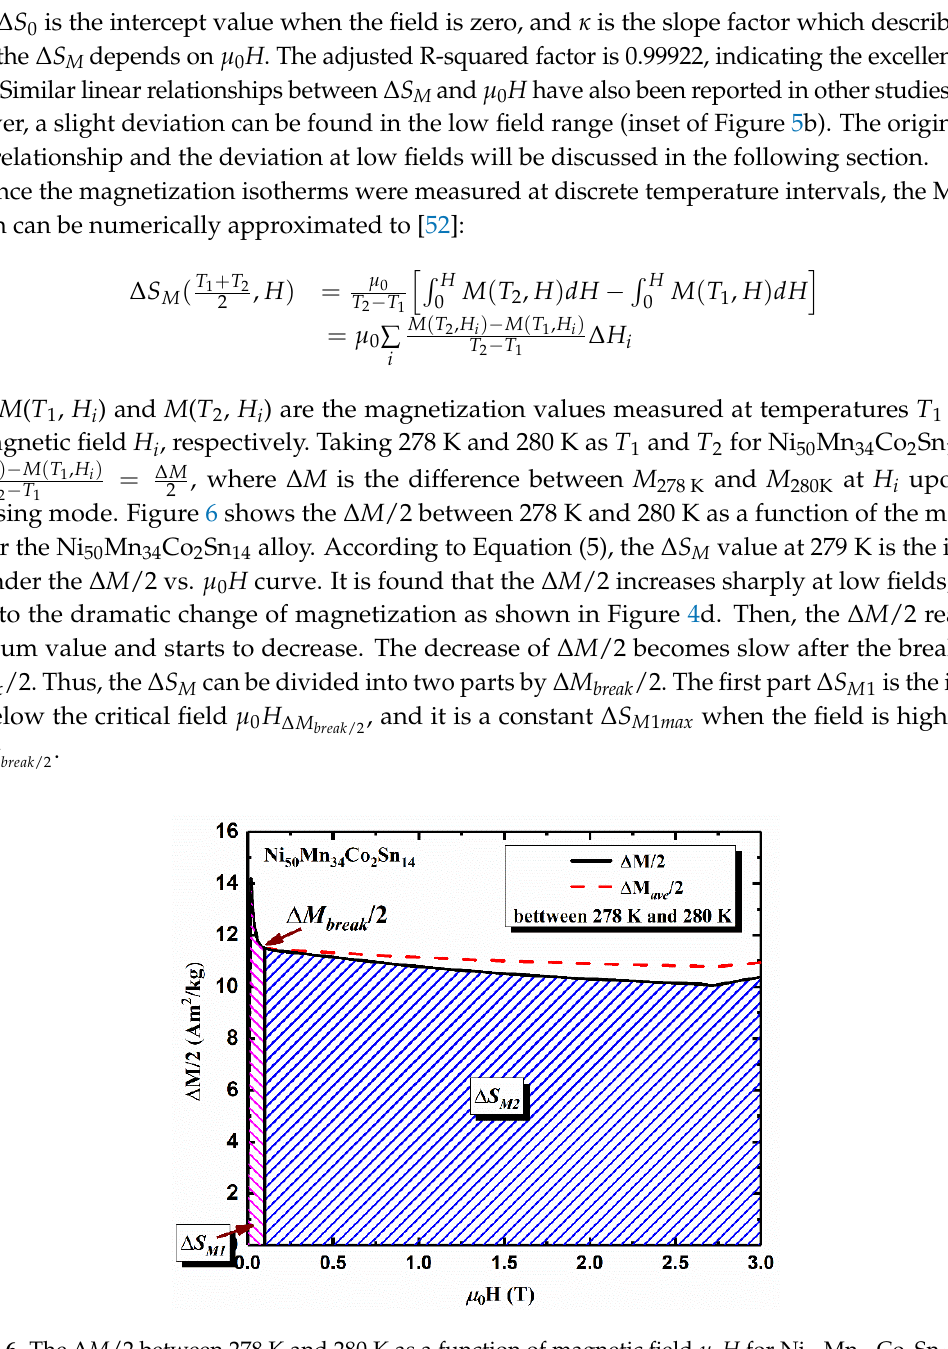
Figure 6. The Δ M /2 between 278 K and 280 K as a function of magnetic field μ 0 H for Ni 50 Mn 34 Co 2 Sn 14